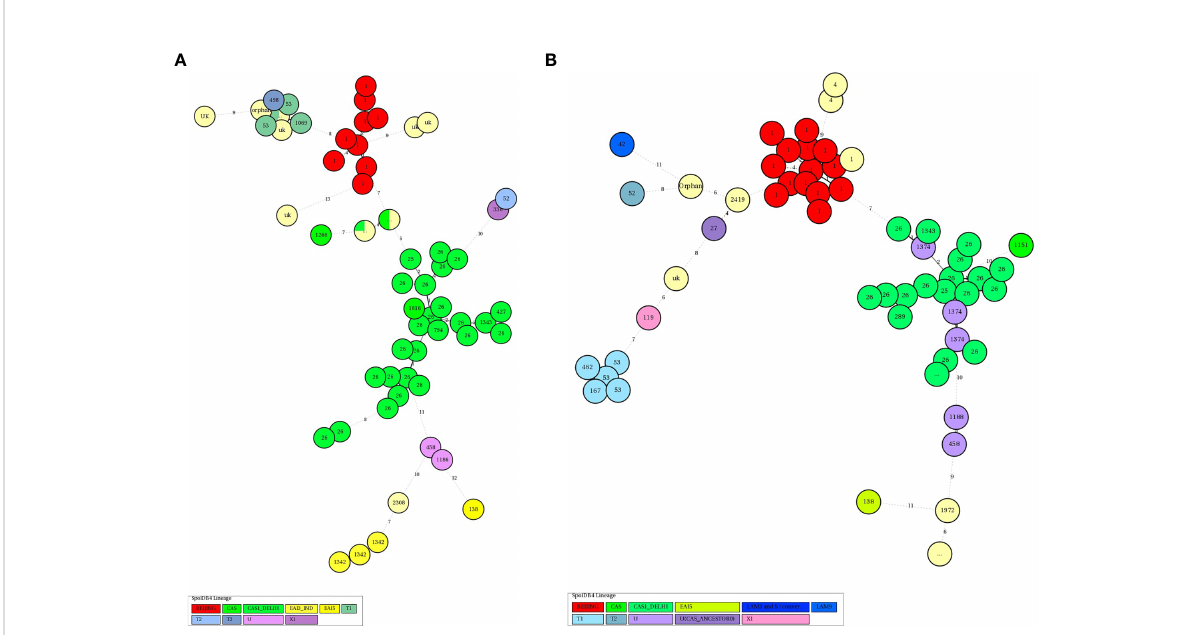
FIGURE 3 (A) The Hunter-Gaston discriminatory index of MIRU-VNTR alleles of TB isolates from HIV-Negative patients MIRU: Mycobacterial Interspersed Repetitive Units, VNTR, Variable Number Tandem Repeats; HGDI, Hunter-Gaston Diversity index. The allelic diversity of the loci was classi fi ed as highly discriminant [Hunter-Gaston Index (HGI) >0.6], moderately discriminant (HGI ≥ 0.3 to ≤ 0.6), and poorly discriminant (HGI < 0.3). (B) The Hunter-Gaston discriminatory index of MIRU-VNTR alleles of TB isolates from HIV- TB co-infected